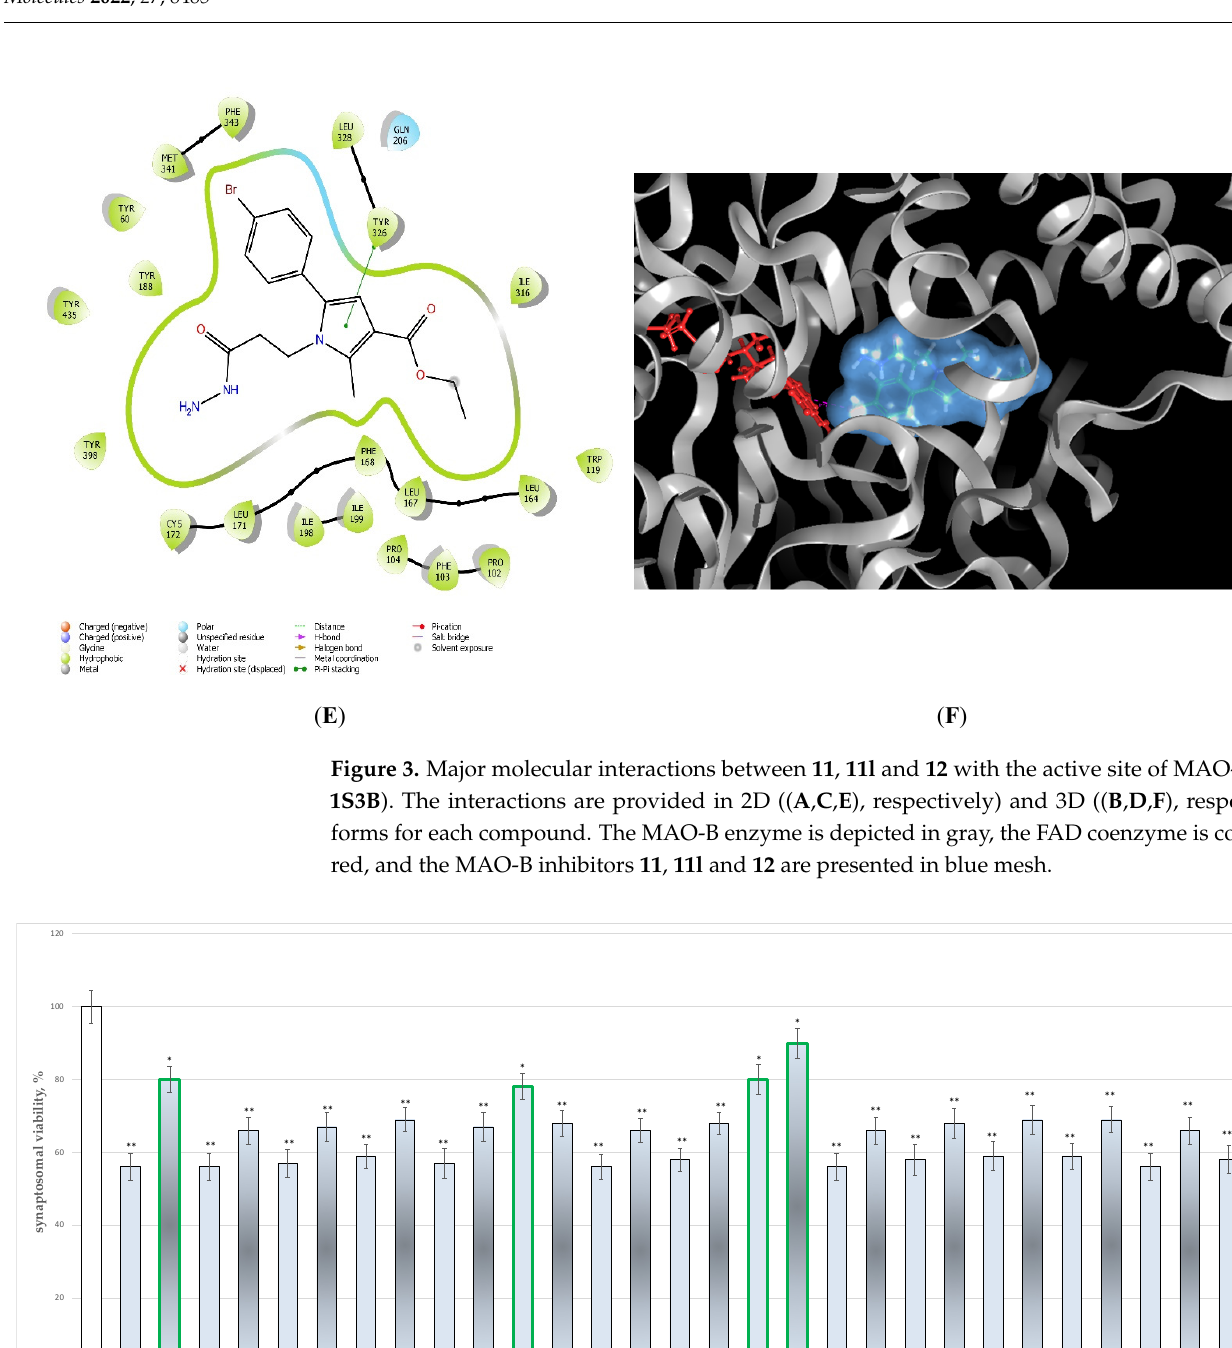
Figure 4. Effects of compounds 11 , 11a – 11x , 12 and 12a – 12x (100 µ mol), applied alone, on synaptoso- mal viability. * p < 0.05; ** p < 0.01 against the control (untreated synaptosomes). The green outline indicates the most promising